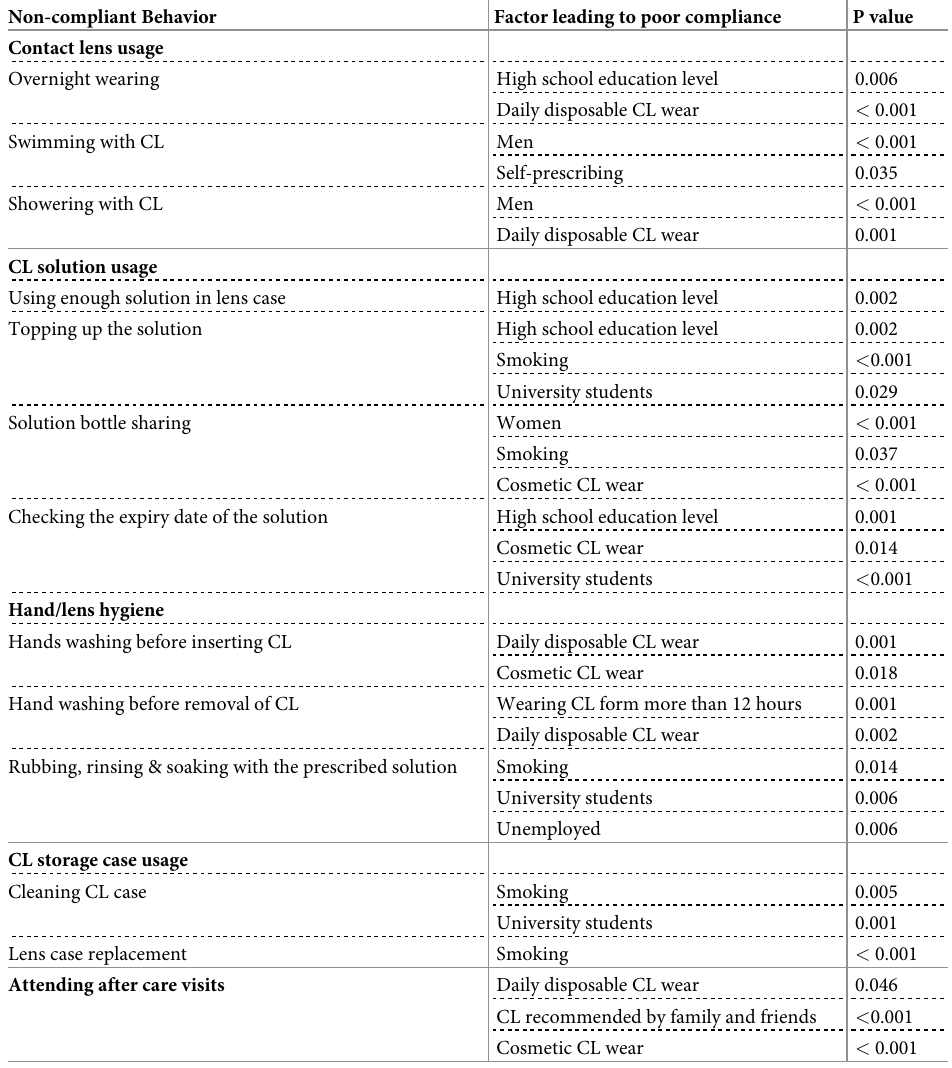
Table 4. Non-compliant behaviors and their associated risk factors (Mann-Whitney U-test and Kruskal-Wallis test) in Sudanese adult contact lens (CL)